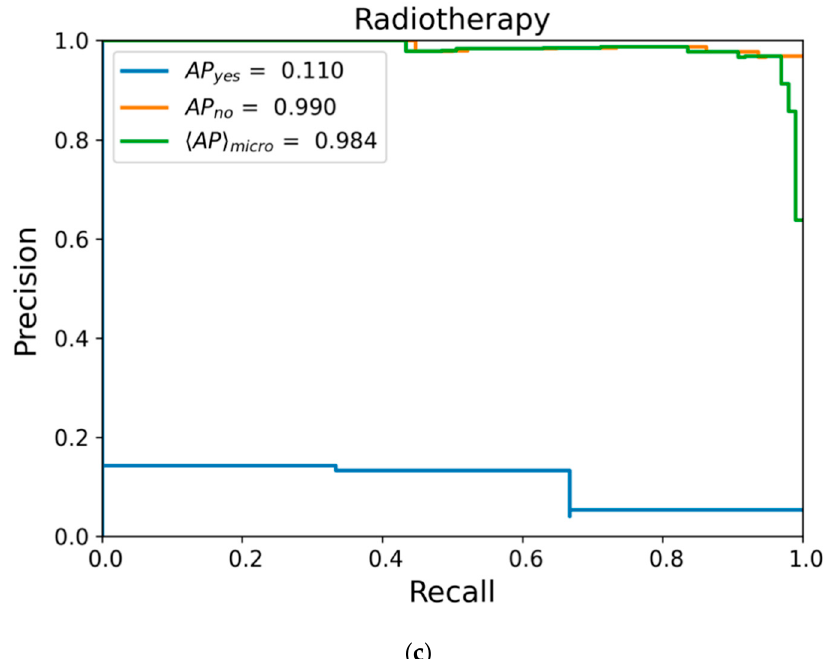
Figure 6. ( a ) Precision ‐ recall curve for surgery; ( b ) Precision ‐ recall curve for radiochemotherapy; ( c ) Precision ‐ recall curve for radiotherapy; AP = average precision (area under precision ‐ recall curve), <AP> micro = micro ‐ averaged over both classes.